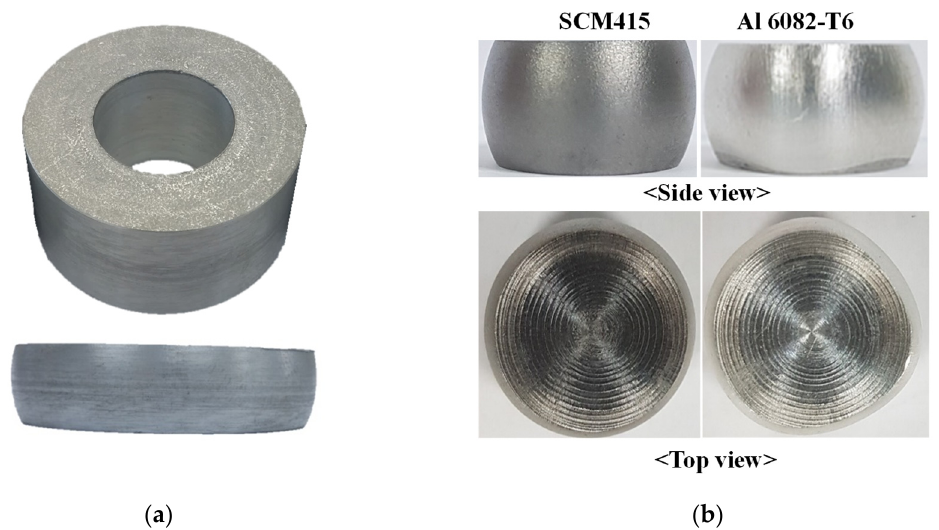
Figure 12. Instability of aluminum alloys during upsetting: ( a ) Ring compression; ( b ) Solid cylin- der compression.